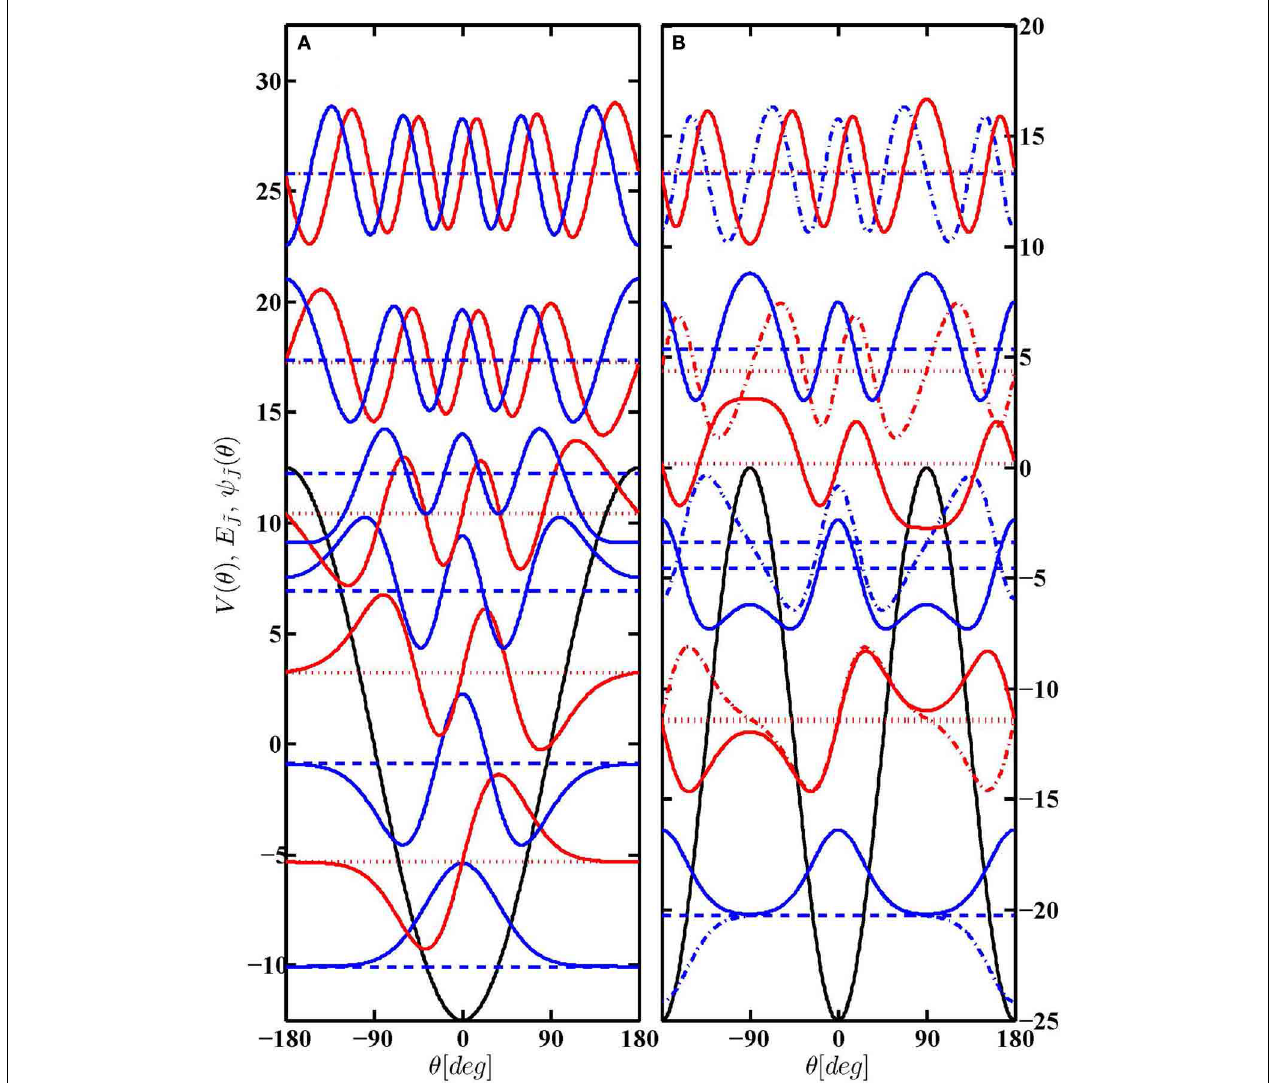
FIGURE 1 | Eigenenergies and eigenfunctions pertaining to Hamiltonian of Equation (1). Left panel (A) : purely orienting interaction with η = 12 . 5 ,ζ = 0. Right panel (B) : purely aligning interaction with η = 0 ,ζ = 25, where the tunneling doublets can be understood as